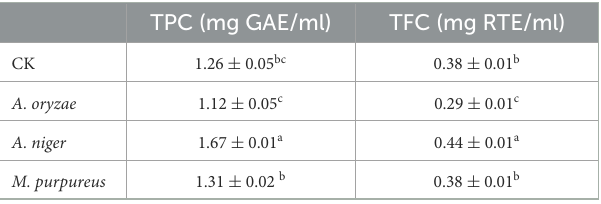
TABLE 1 Changes in the total phenolic content (TPC) and total flavonoid content (TFC) after fermentation of different strains.